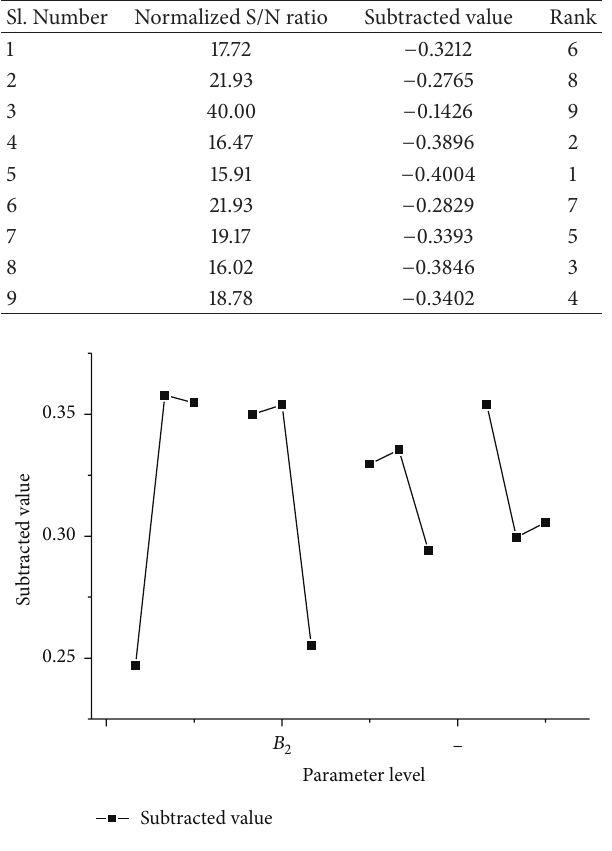
Figure 3: Graph for subtracted value.